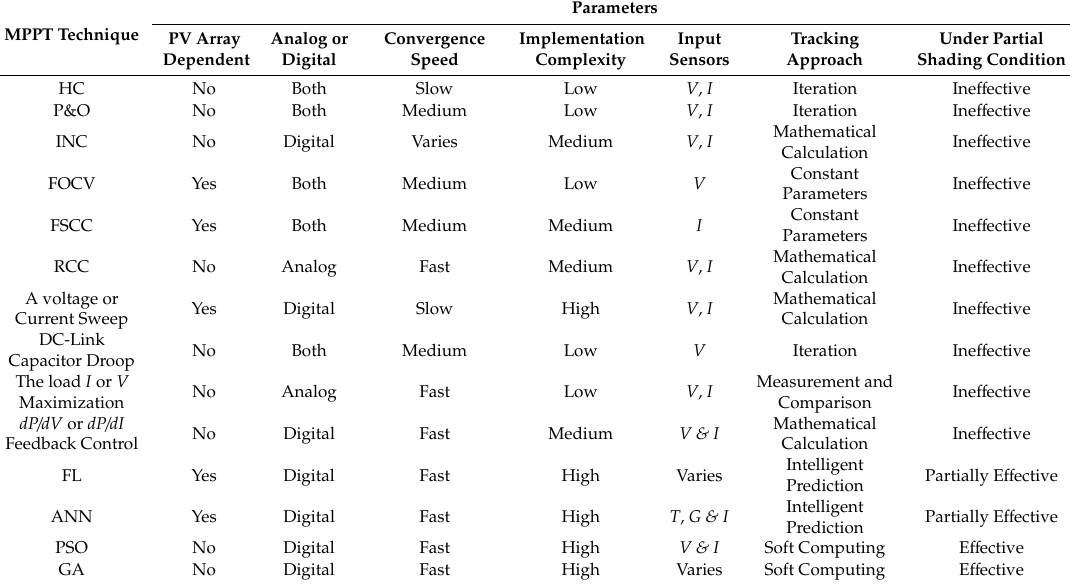
Table 2. Comparison of major MPPT techniques and their limitations